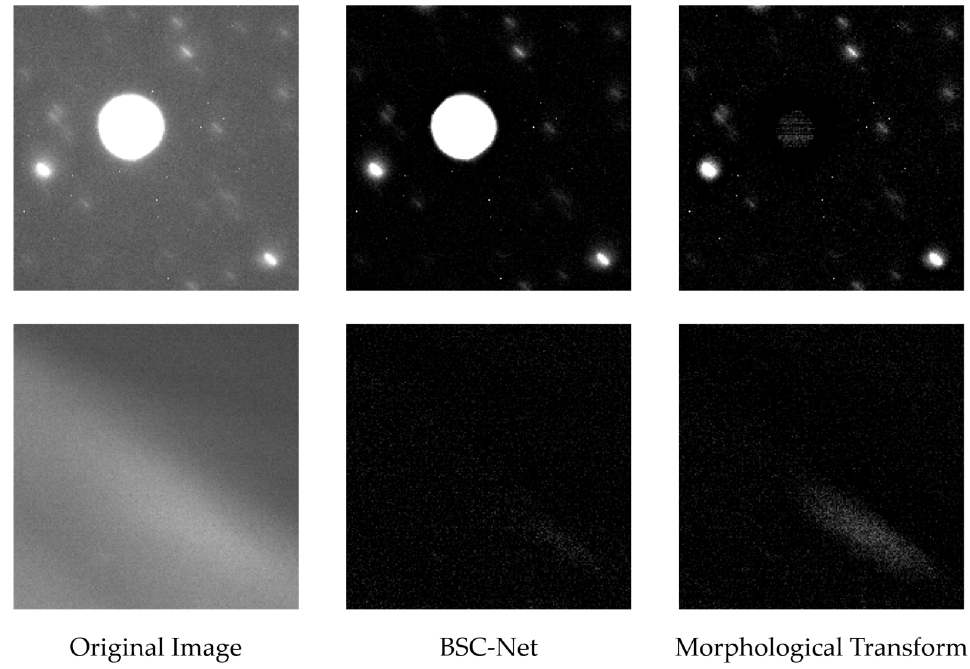
Figure 15. Processing results of BSC-Net and the morphological transform.